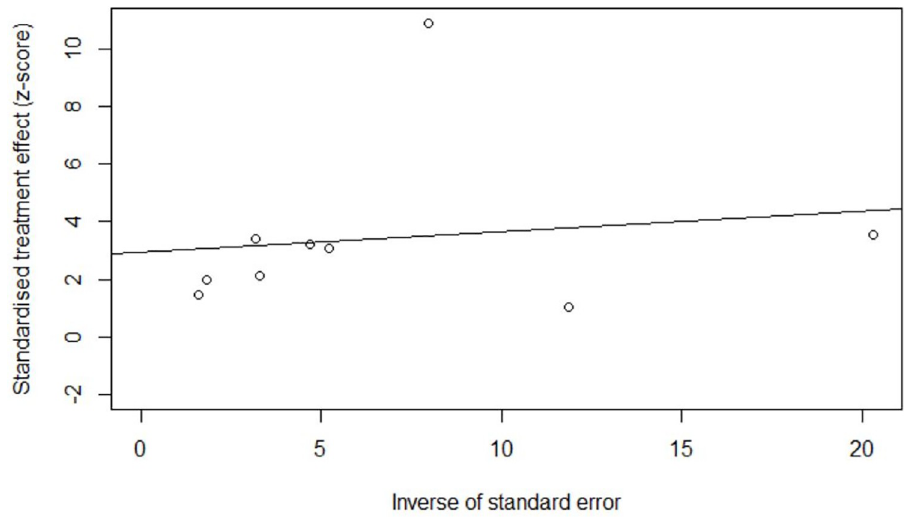
Fig 4. Publication bias assessment: Radial plot for per-protocol meta-analysis of tuberculosis and risk of cardiovascular disease and related mortality.